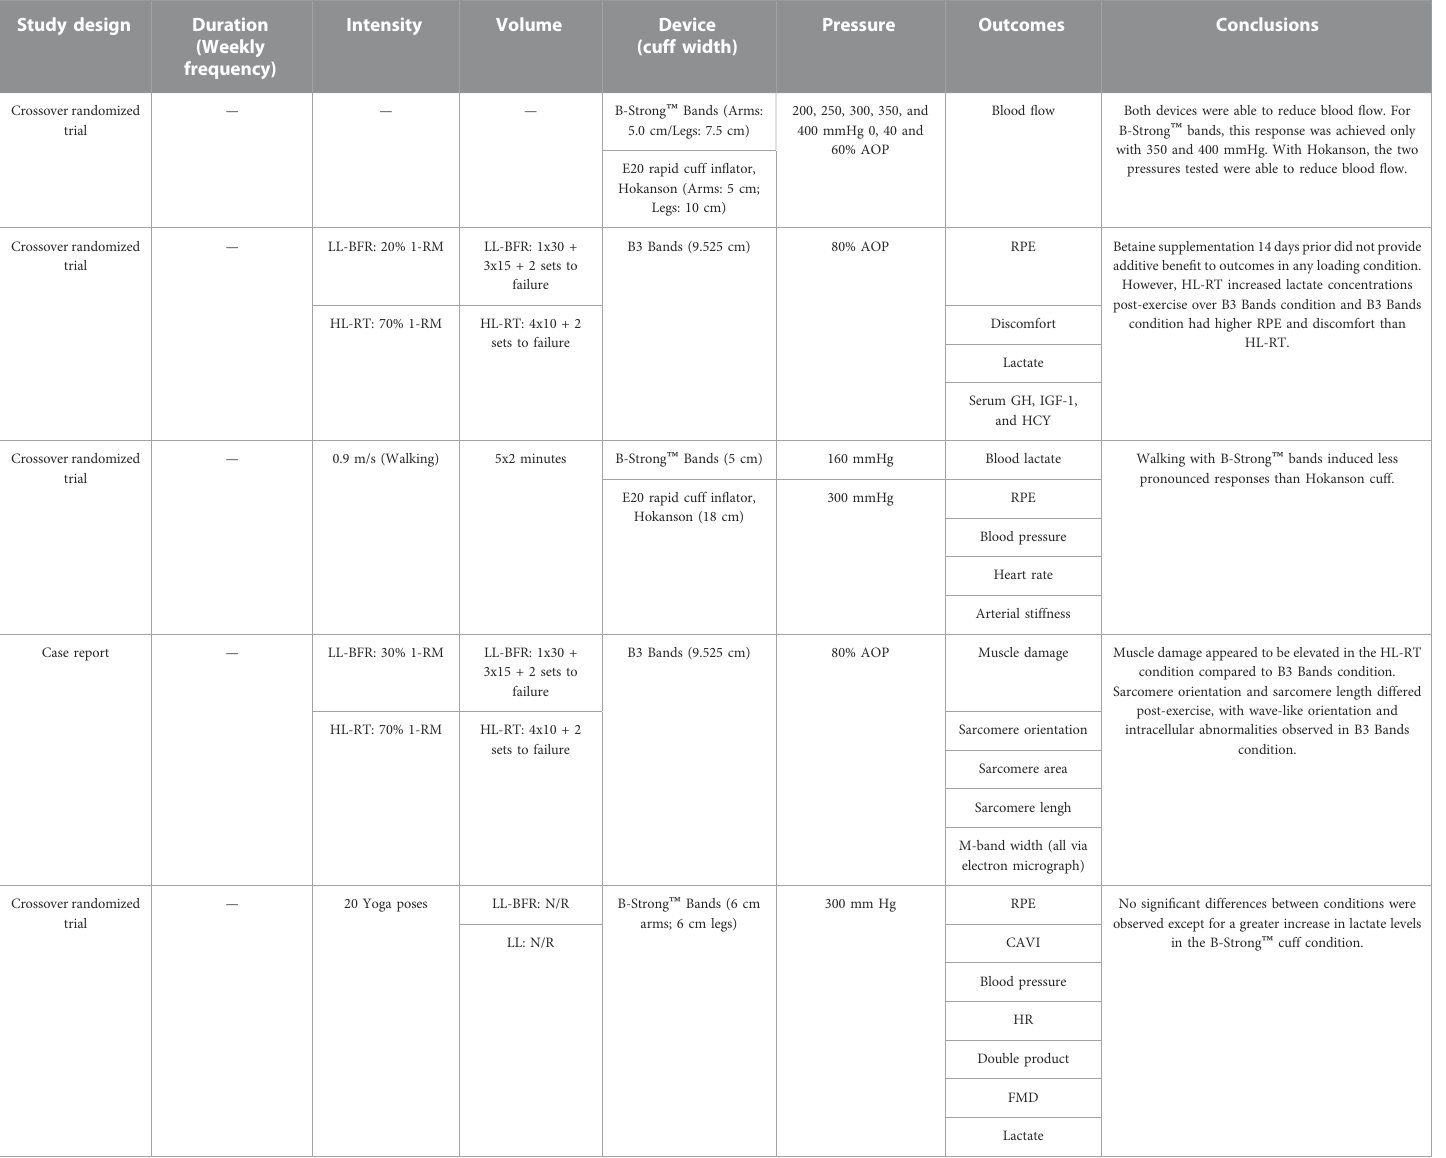
— — B-Strong ™ Bands (Arms: